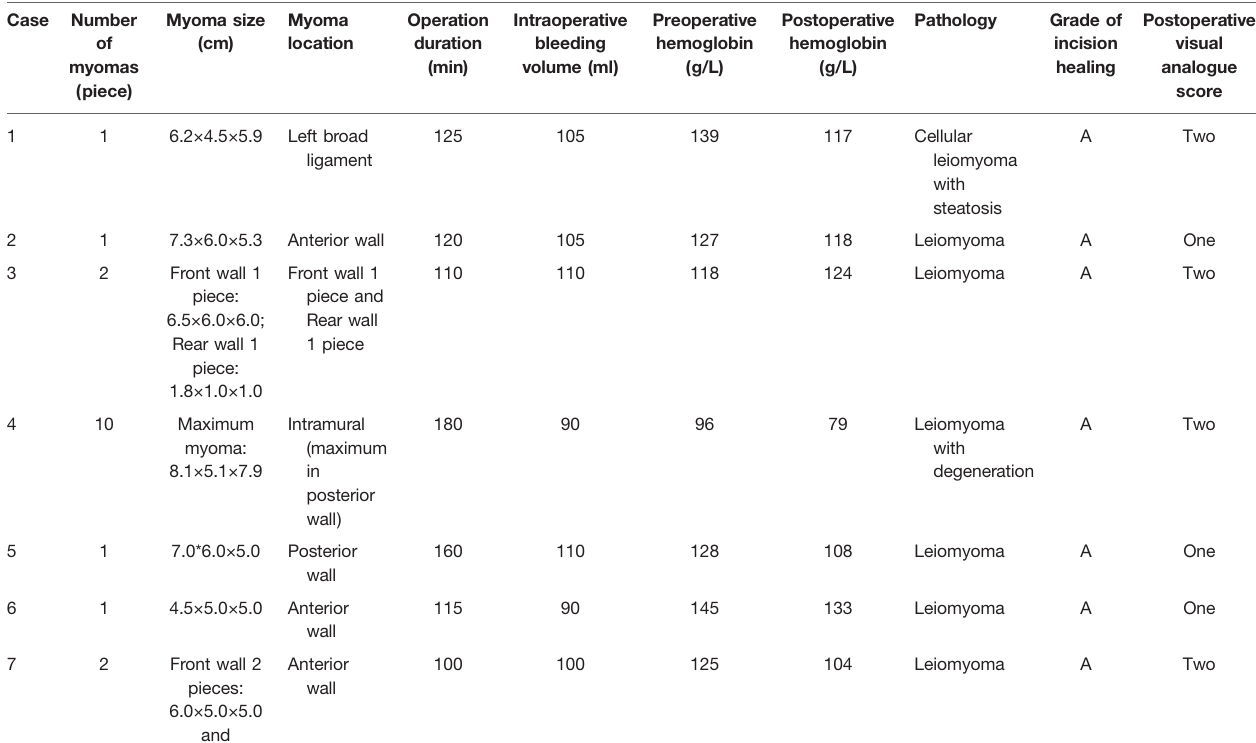
TABLE 3 | Single-hole laparoscopic myomectomy via the abdominal scar approach. Case Number of myomas